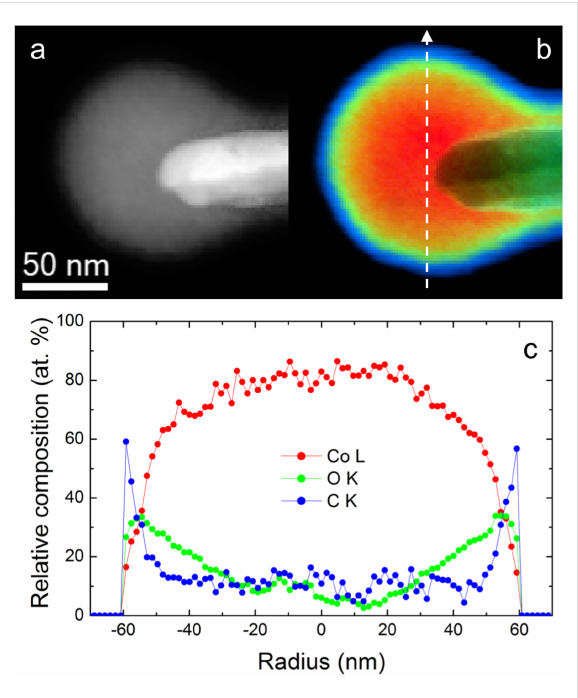
Figure 4: STEM-EELS compositional analysis of the cobalt nano- sphere with 110 nm diameter. (a) Reference image in Z contrast. (b) Colored chemical map, including the relative compositions of Co (red), O (green) and C (blue). (c) Compositional line profile extracted along the white arrow in